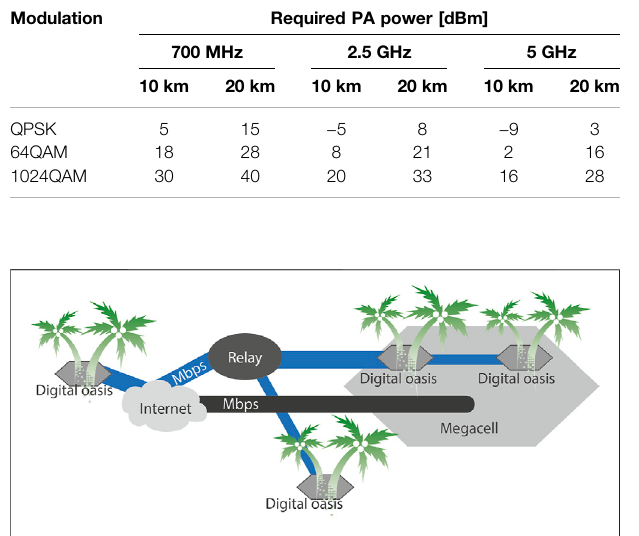
FIGURE 5 | Backhaul chain options in different cases. Note that the mega-cell needs just one